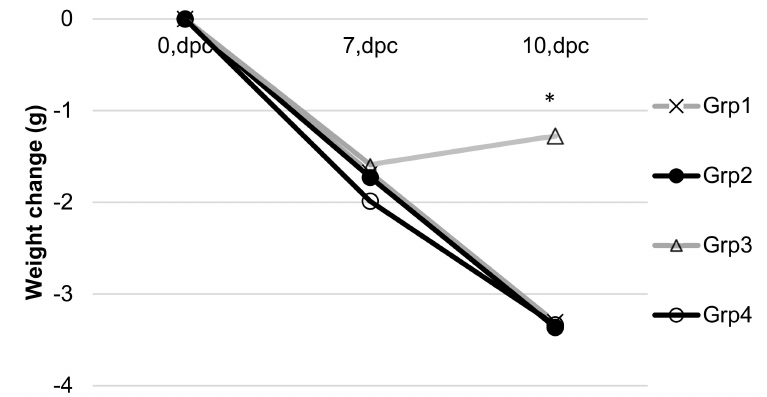
Figure 7. Weight change following challenge with live Coccidioides arthroconidia. Asterisk (*) indicates a statistically significant di ff erence between Grp 3 and Grp 4 at 10 dpc ( p < 0.05). Treatment groups are as described in Figure